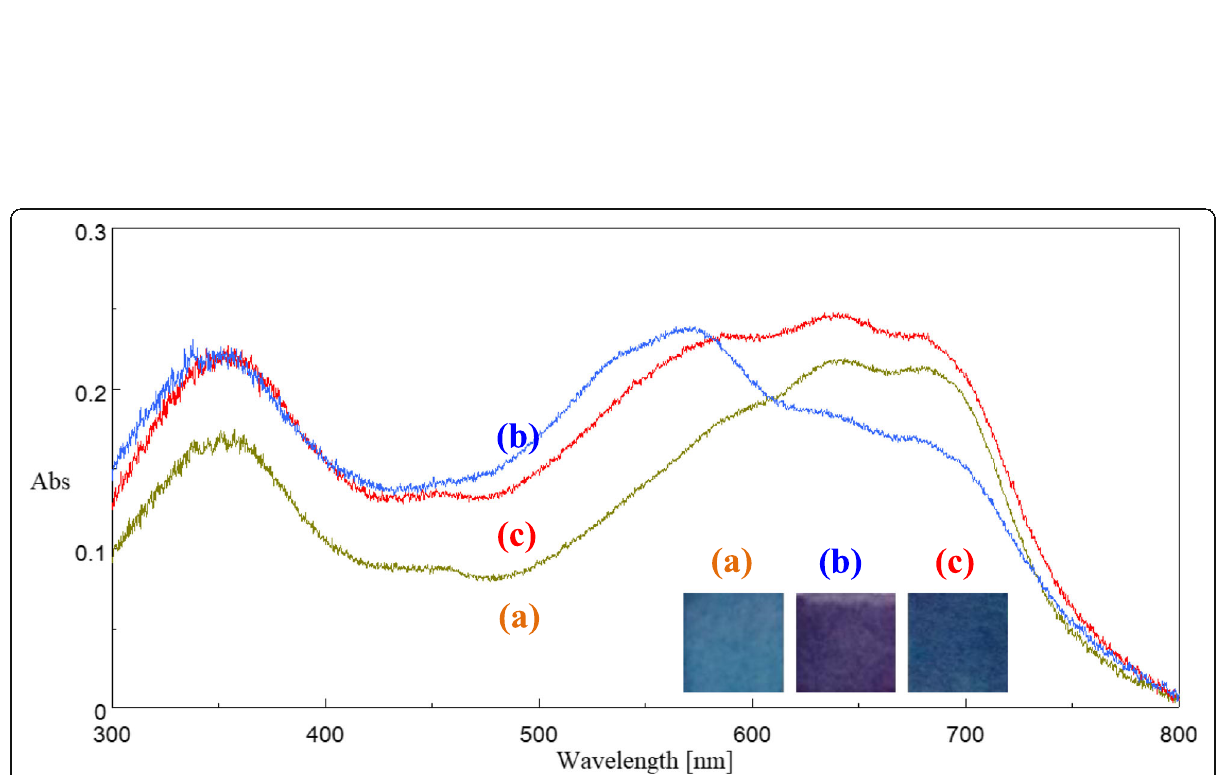
Fig. 2 Kinetic profiles of PAN on CC. CC pieces of 2 × 2.5 cm (0.03 g) put in contact with 10 mL of 50 μ M PAN solutions at pH = 11 for different contact times. The black line is the fitting according to a film diffusion limiting process model